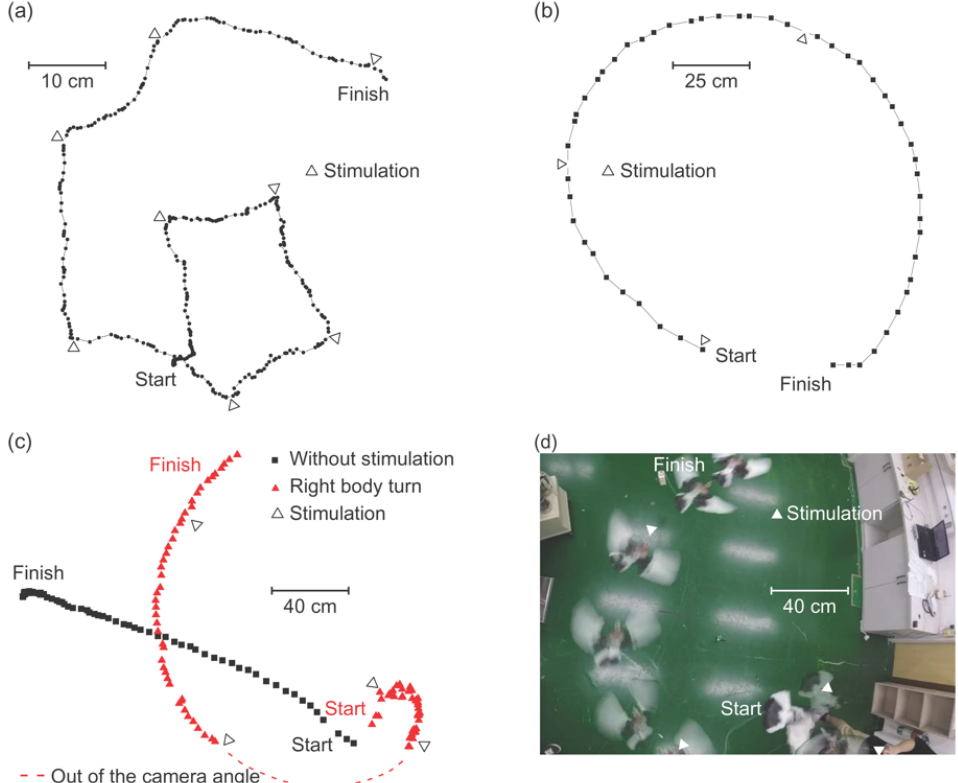
Figure 4. Behavioral changes on electrical current stimulation of the midbrain nucleus. A pigeon showed ( a ) right body turn on the ground and ( b ) rightward turn during flight during electrical stimulation. ( c ) Without stimulation, the pigeon flew forward (black square dots), and with stimulation, flew rightward (red triangular dots). ( d ) stroboscopic image of the rightward flight of the pigeon by electrical stimulation.